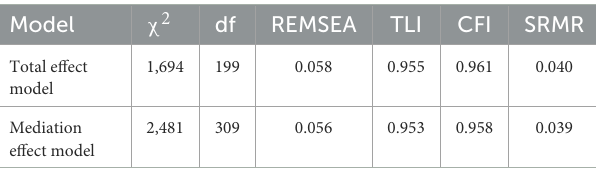
TABLE 3 Total effect model and mediation effect model fitting index